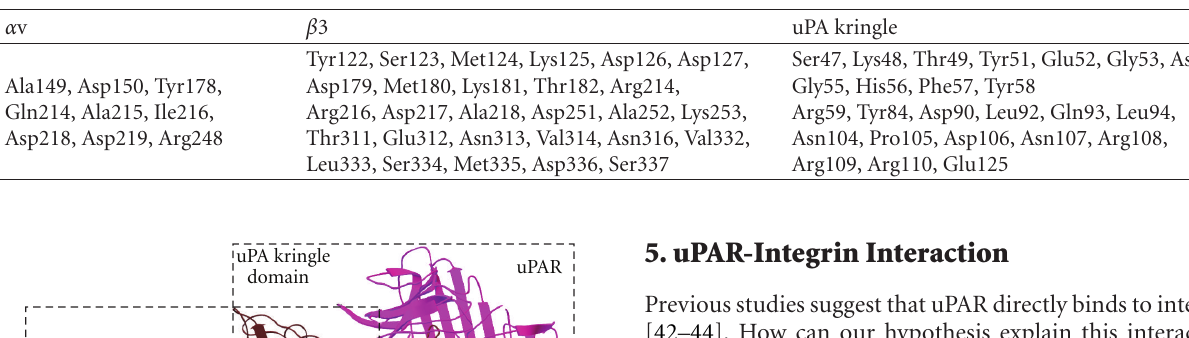
Table 1: Amino acid residues involved in α v β 3-uPA kringle interaction in the docking model. Amino acid residues at the binding interface (within the 6 Angstrom) were selected using Swiss pdb viewer (v. 4.02).